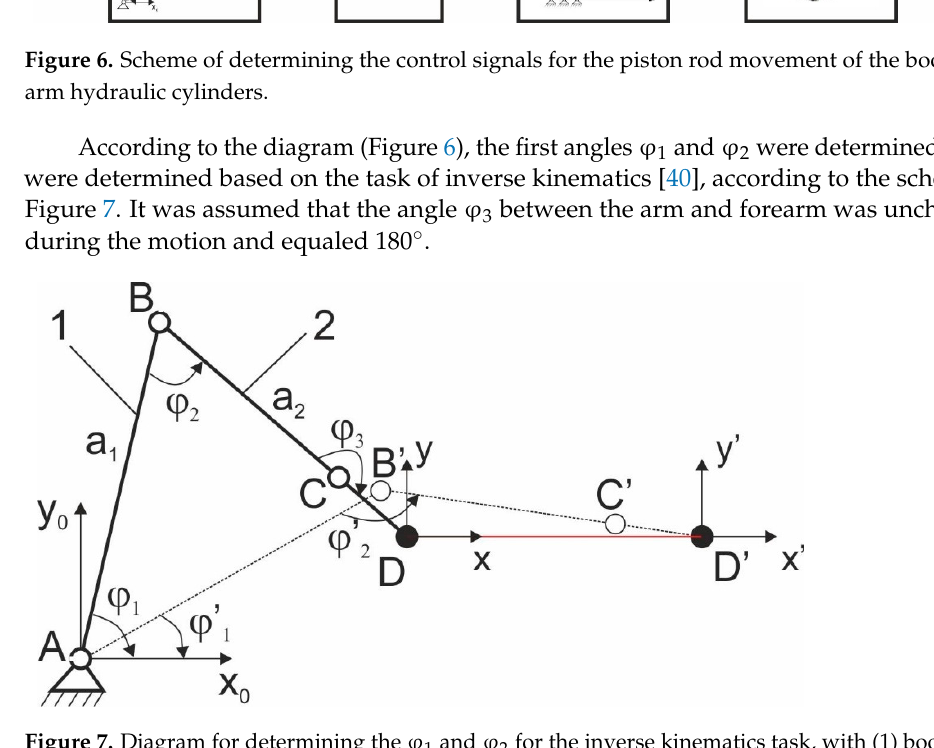
Figure 7. Diagram for determining the ϕ 1 and ϕ 2 for the inverse kinematics task, with (1) boom, and (2) arm and forearm. (2) arm and